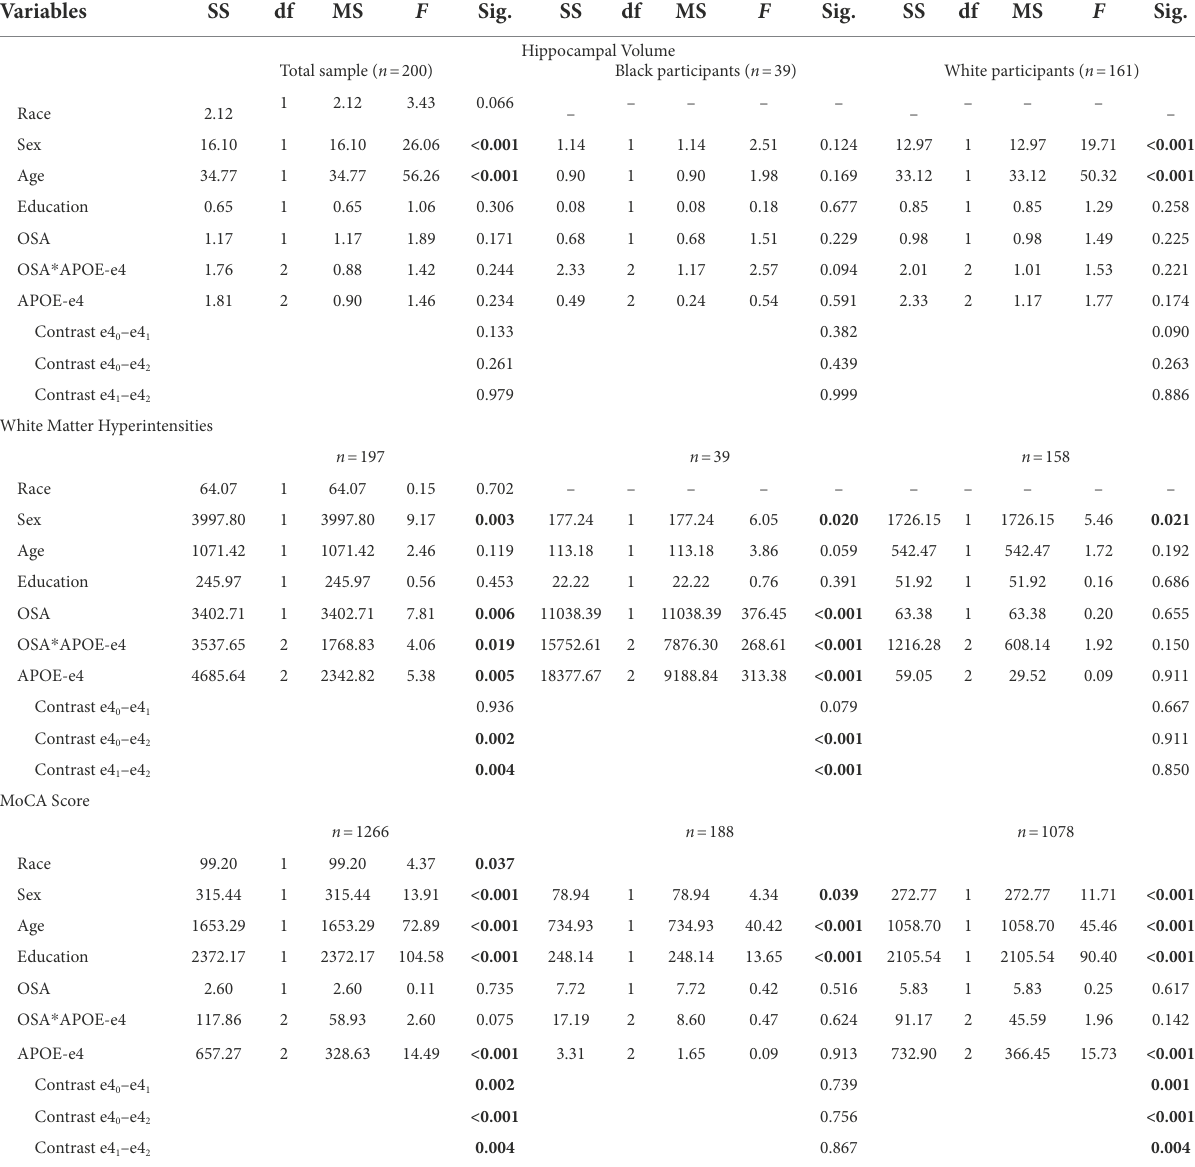
TABLE 4 Two-way ANOVA analyses of the effects of APOE-e4 and OSA on Hippocampal & White Matter hyperintensity volume, and MoCA performance. Variables